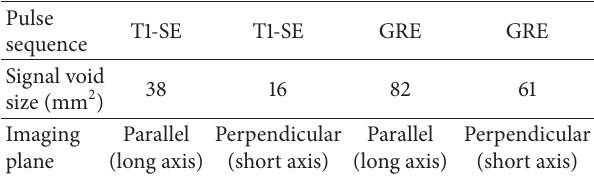
Table 1: Summary of MRI artifacts at 3 Tesla for the tissue